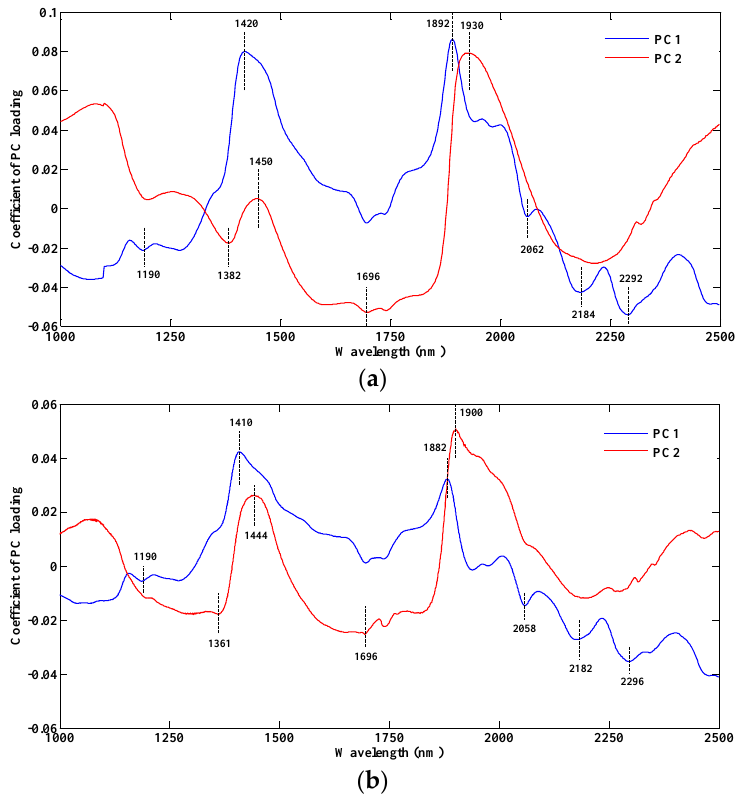
Figure 5. Characteristics of loading line plots based on PCA. ( a ) First three PC loading lines based on dispersive NIR data; ( b ) First two PC loading lines based on FT-NIR data.